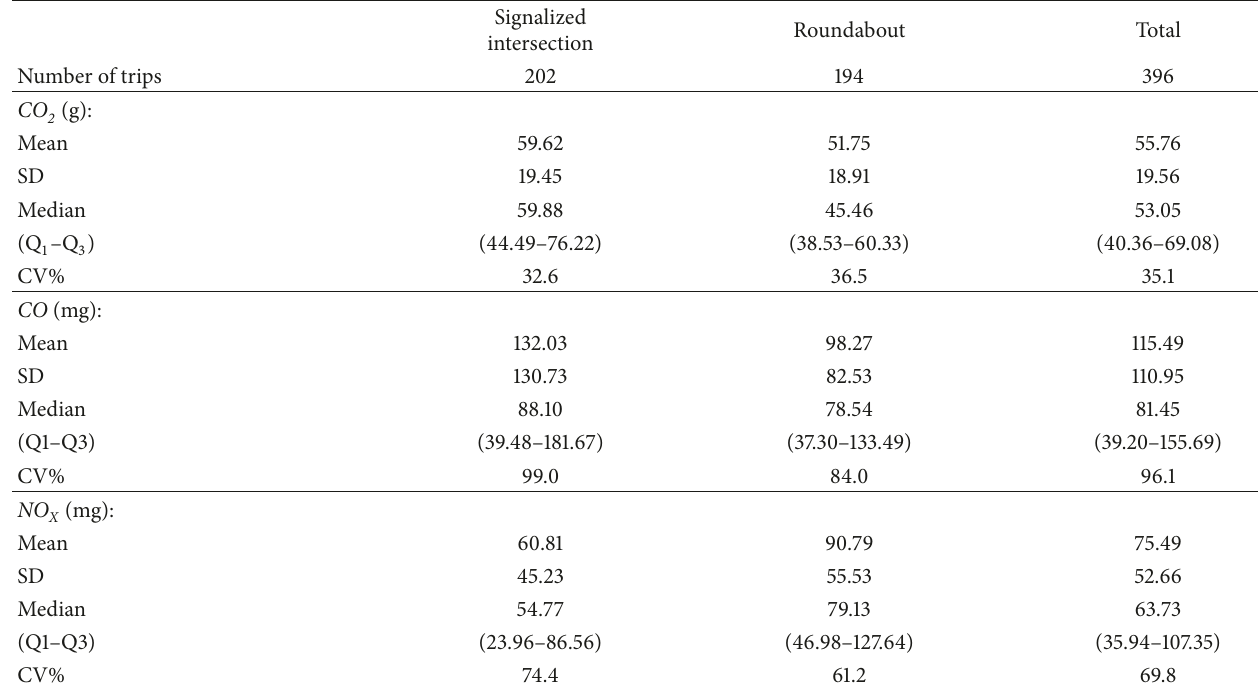
Table 5: Descriptive statistics for CO 2 , CO, and NO 𝑋 emissions by intersection control